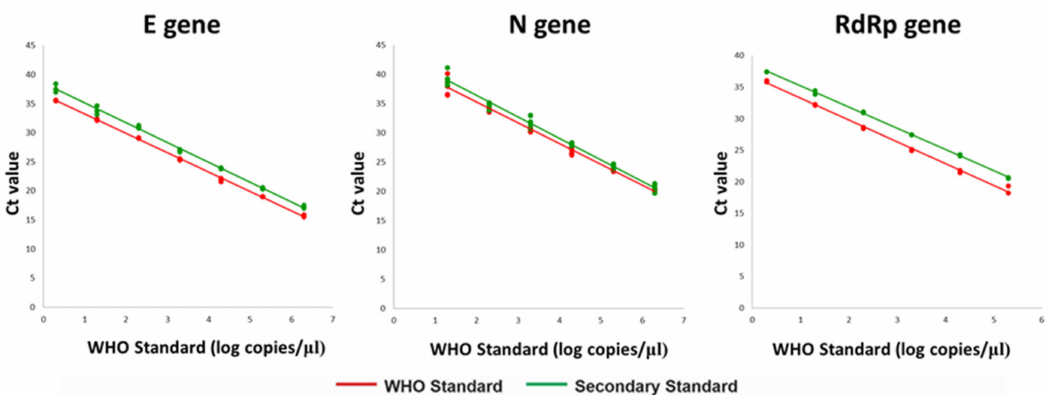
Figure 1. Calibration of the secondary standard against the WHO Reference Standard. The Ct values obtained in the parallel amplification of the E, N, and RdRp genes from different concentrations of the SARS-CoV-2-SStd (green line) and the WHO Reference Standard (red line) are